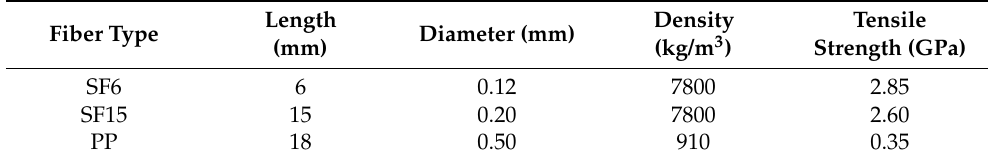
Table 2. Properties of SF and PP fibers.